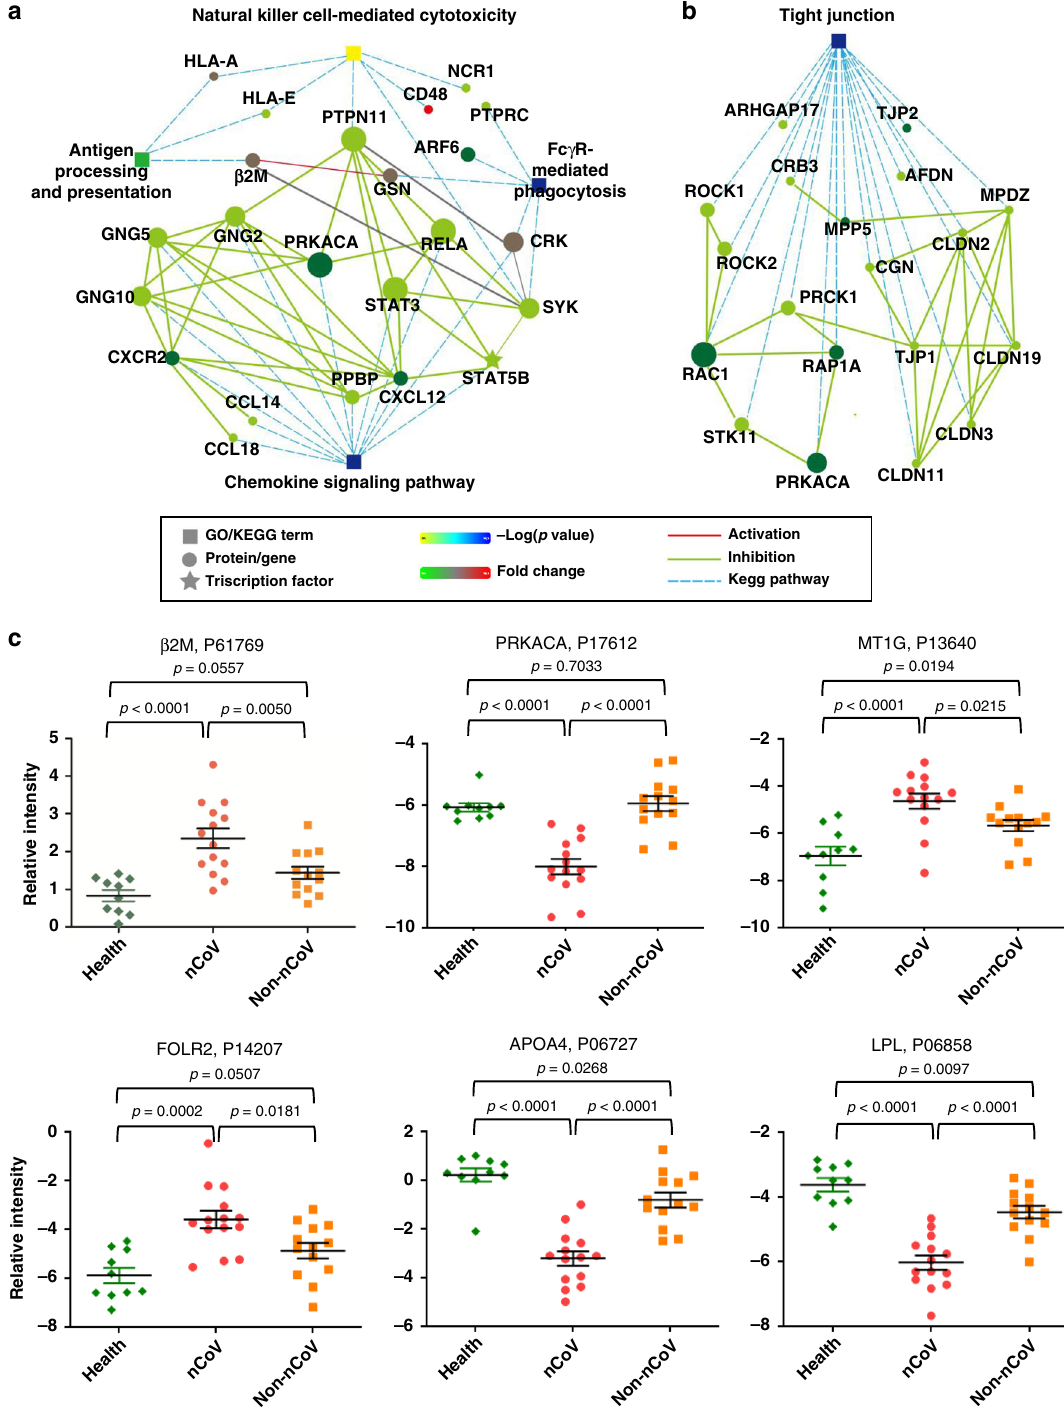
Fig. 2 Functional analysis of 1986 speci fi c proteins in COVID-19 patients. a The interaction diagram of the Fc γ R-mediated phagocytosis, chemokine signaling pathway, natural killer cell-mediated cytotoxicity and antigen processing and presentation. Network nodes and edges represent proteins and protein – protein associations. Green solid lines represent inhibition; the red solid lines represent activation; the blue dotted lines represent the KEGG pathways. Color bar from red to green represents the fold change of protein level from increasing to decreasing. The signi fi cance of the pathways represented by − log( p value) (Fisher ’ s exact test) was shown by color scales with dark blue as most signi fi cant. b The interaction diagram of proteins involved in tight junctions. Green solid lines represent inhibition; blue dotted lines represent the KEGG pathways. Color bar from red to green represents the fold change of protein level from increasing to decreasing. The signi fi cance of the pathways represented by − log( p value) (Fisher ’ s exact test) was shown by color scales with dark blue as most signi fi cant. c The scatter plot graphs show six proteins, which are potential diagnostic markers for COVID-19. One-way ANOVA was used to analyze the data. For Health group, n = 10; for nCoV group, n = 14; for non-CoV group, n = 13. Data are presented as mean ± SEM. Source data are provided as a Source Data fi